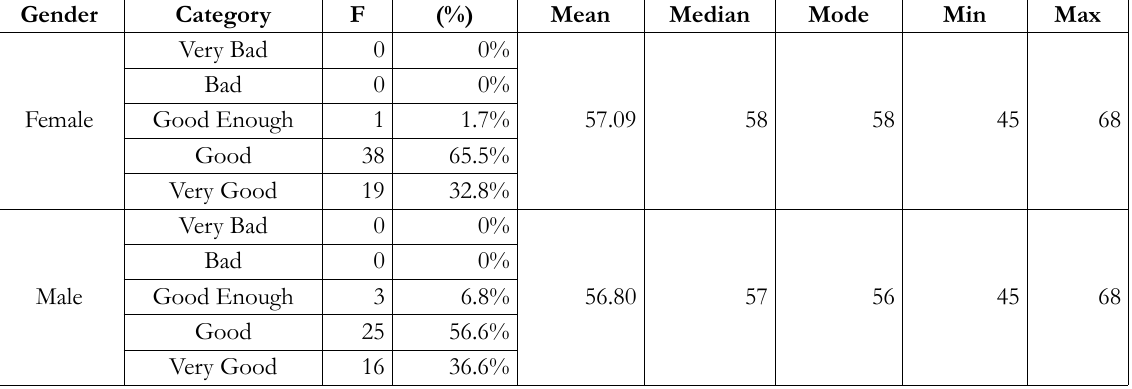
Table 15. Character Description of Ninth Grade